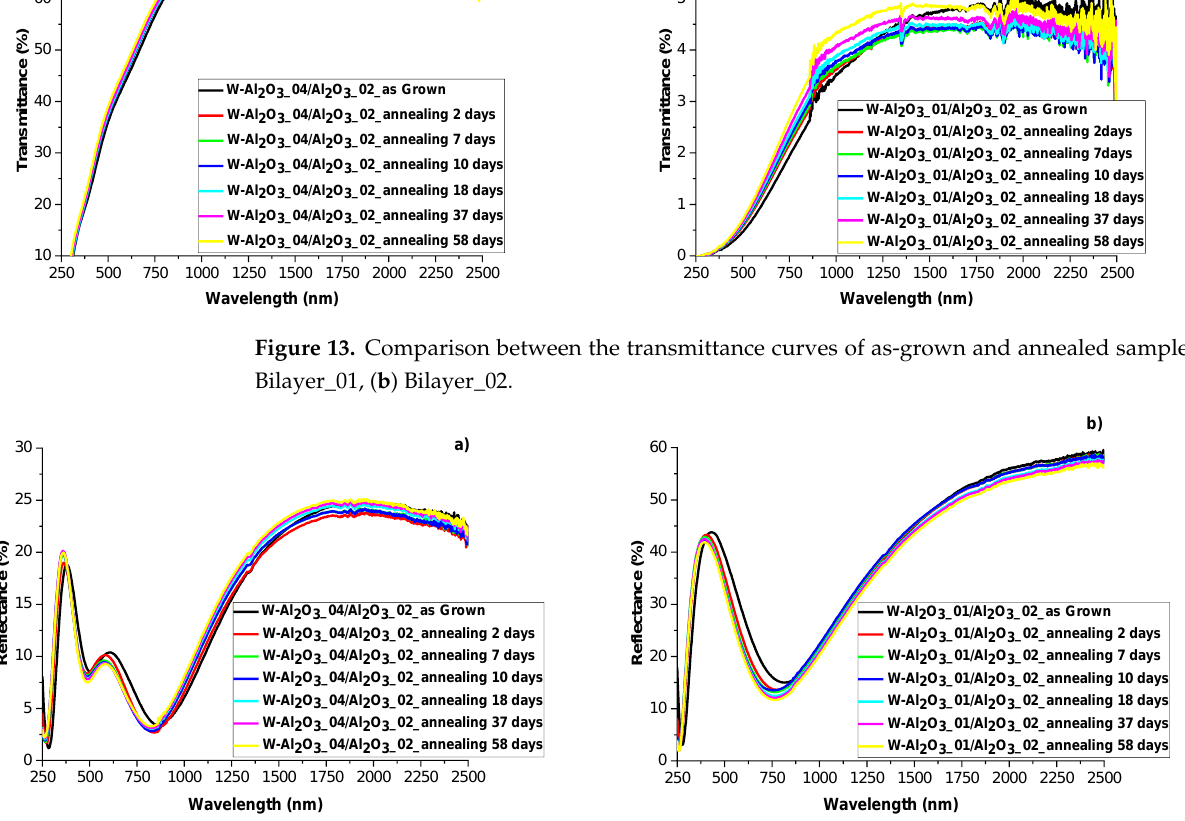
Figure 14. Comparison between the reflectance curves of as-grown and annealed samples: ( a ) Bilayer_01, ( b ) Bilayer_02.